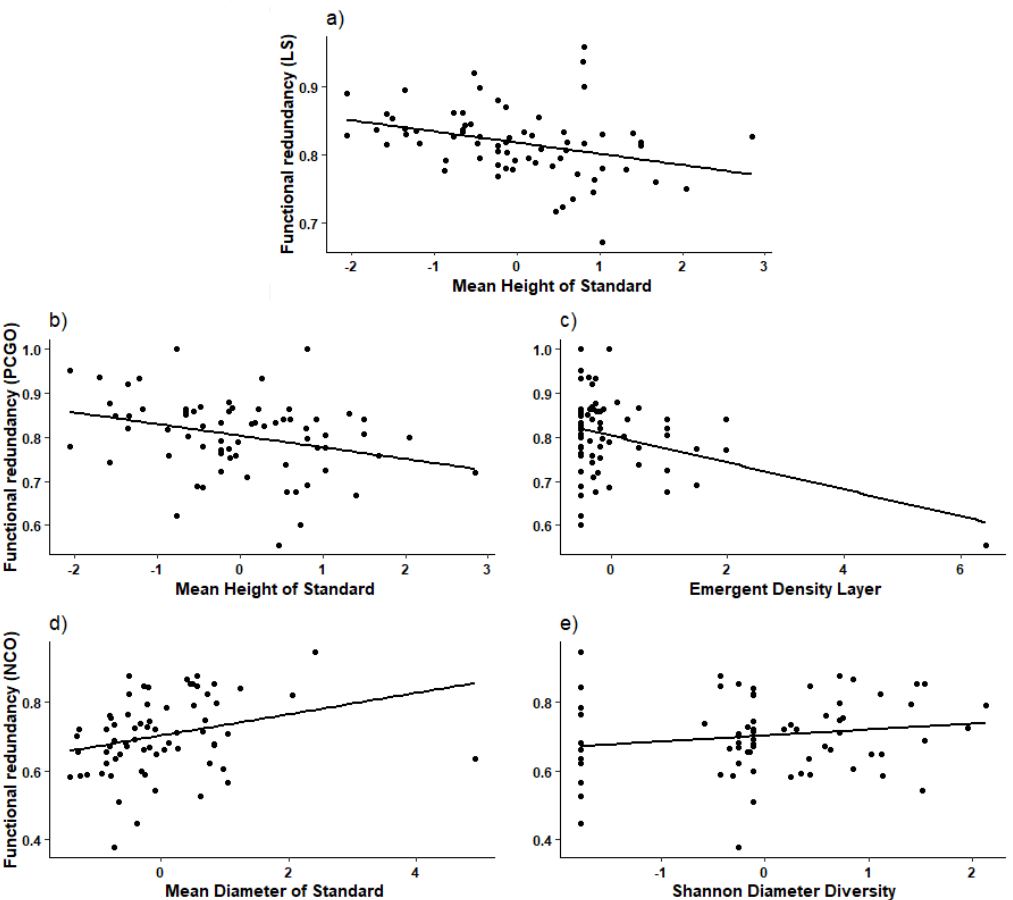
Figure 2. Multiple linear regression between structural parameters and functional redundancy for the Sibillini and Duchessa montane beech forests in the Apennines in Central Italy. ( a ) Lateral spread (LS) with mean height of standards; ( b ) persistent clonal growth organ (PCGO) with mean height of standards; ( c ) PCGO and emergent density layer; ( d ) number of clonal offspring (NCO) and mean diameter of standards; ( e ) NCO and Shannon diameter diversity.